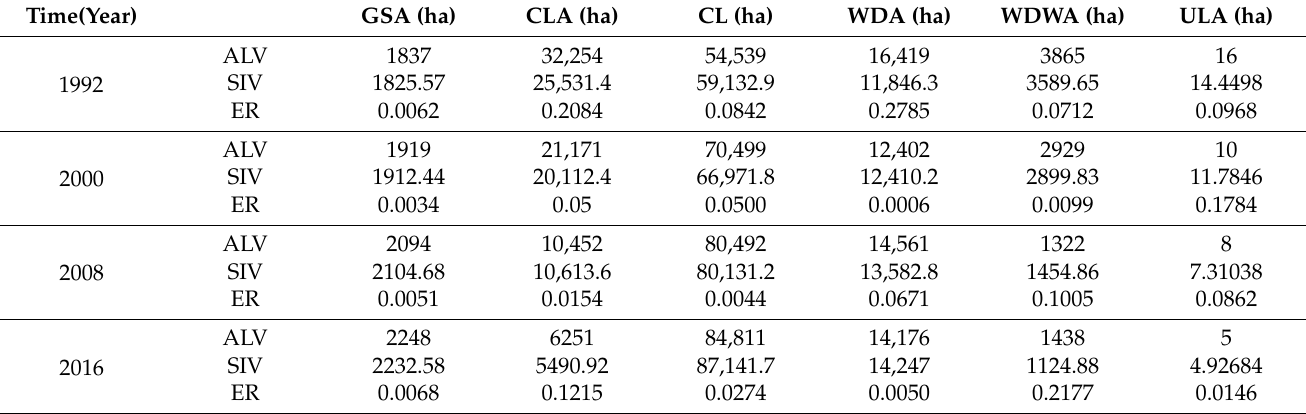
Table 1. Error Testing of the Green Space Composite System.